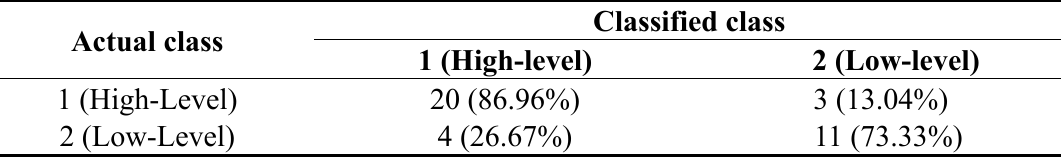
Table 6. RST-DEA-SVM model (model III) results with significant variables and DMU.